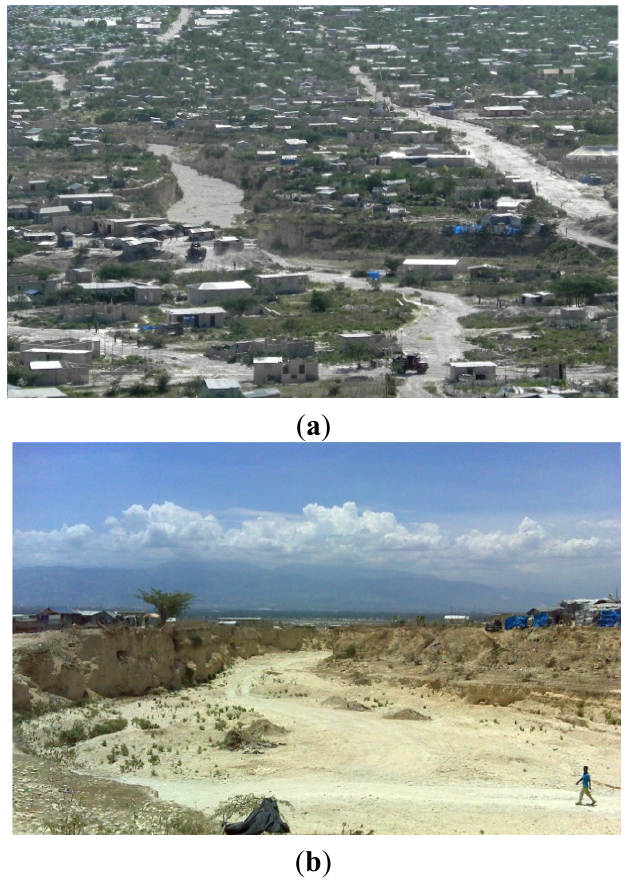
Figure 3. Ravine Lan Couline flow channel from far ( a ) and close ( b